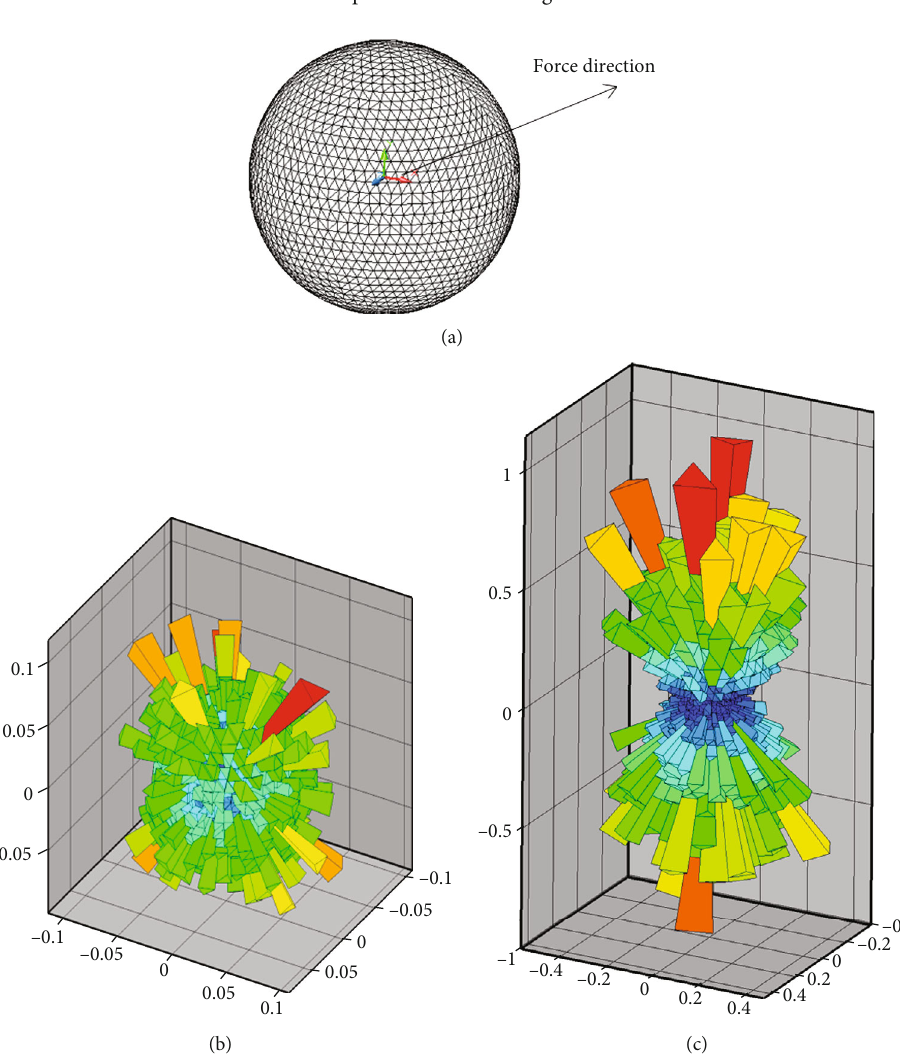
Figure 9: Three-dimensional fabric diagram: (a) statistics of contact force direction and magnitude; (b) tangential contact force distribution; (c) normal contact force